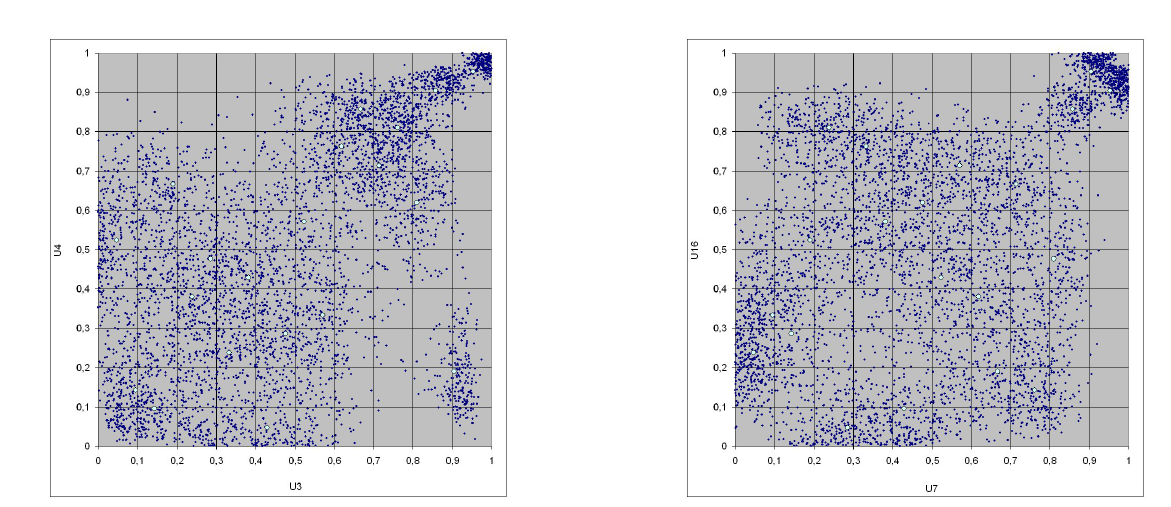
Figure 37: Gamma copula with the rook copula driver, II